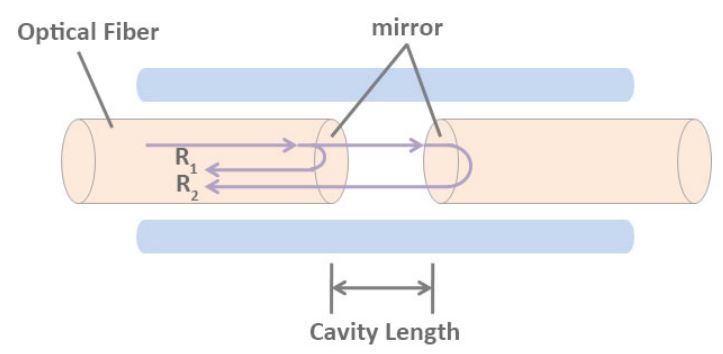
Figure 1. schematic diagram of Fabry–Perot interference cavity. Figure 1. Schematic diagram of Fabry–Perot interference